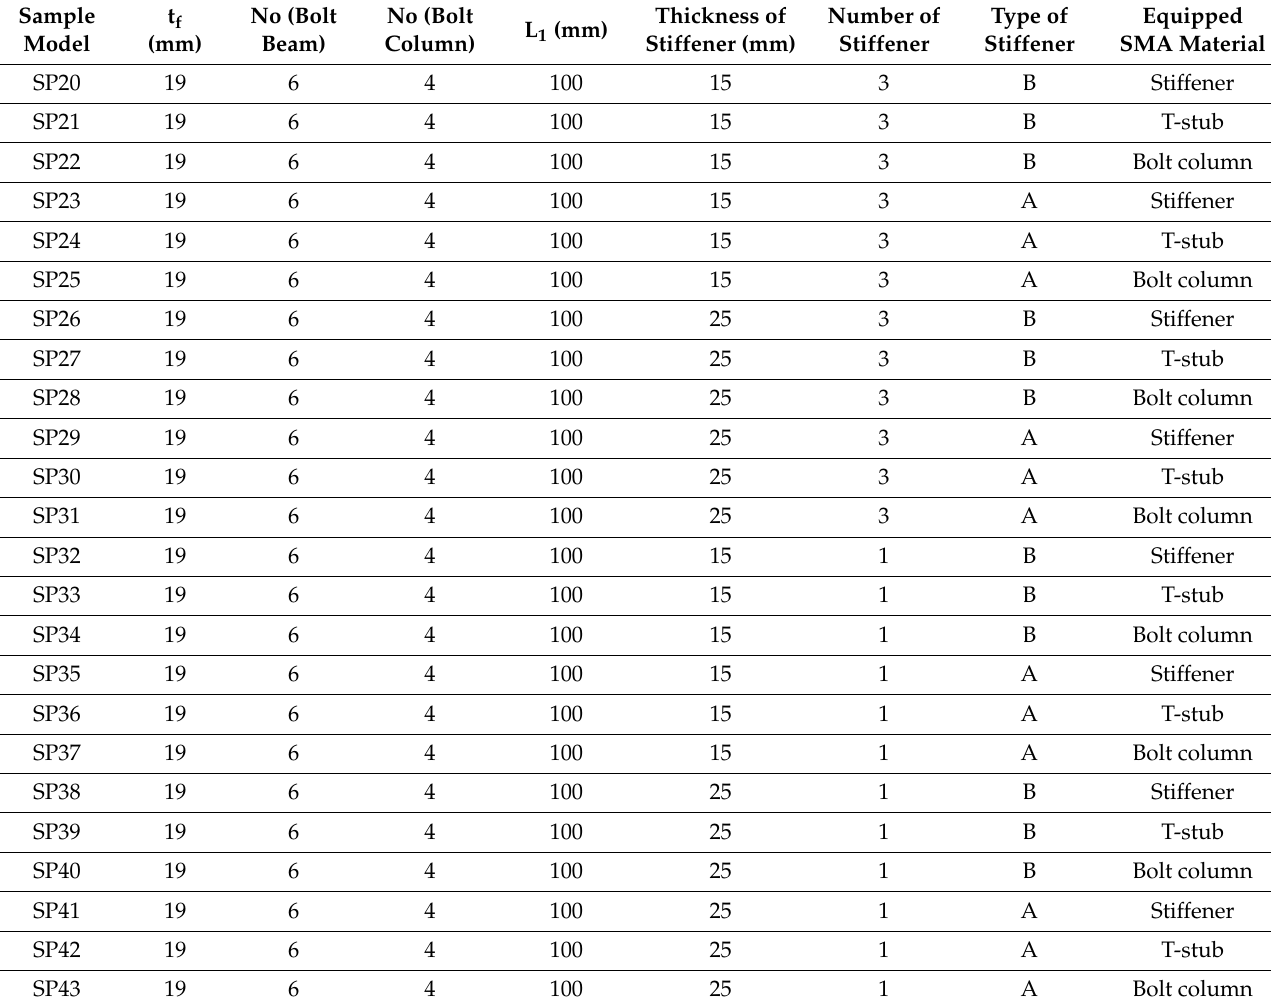
Table 8. Classification and specification of developed